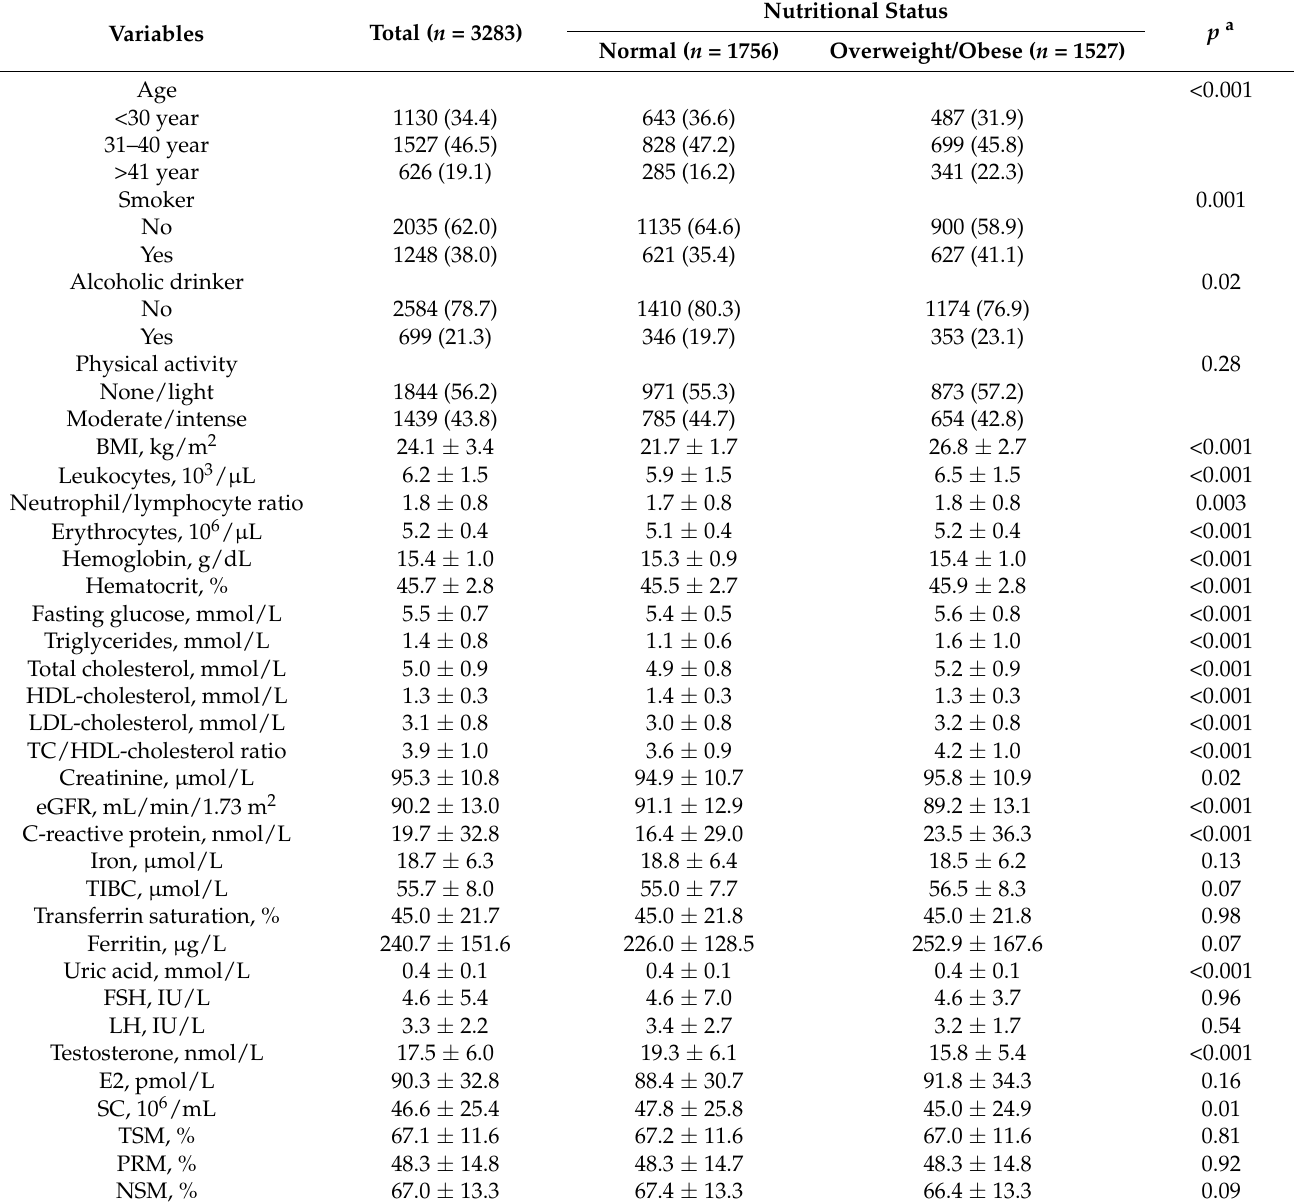
Table 1. Characteristics of men according to nutritional